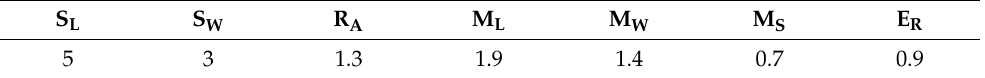
Figure 1. The projected antenna design ( a ) radiating plane ( b ) ground plane.